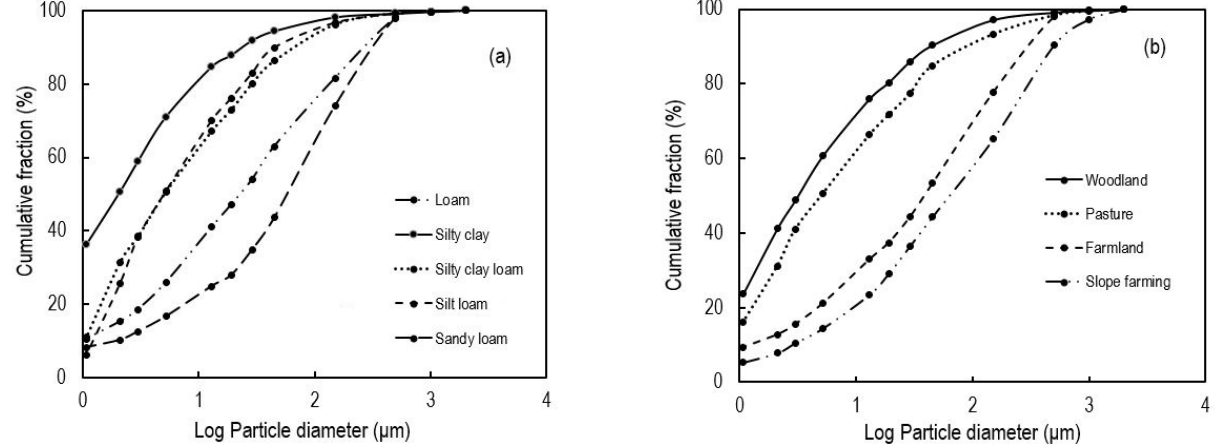
Figure 7. Log–log plots of ( a ) particle size distributions of soil samples based on soil class ( b ) and land use.